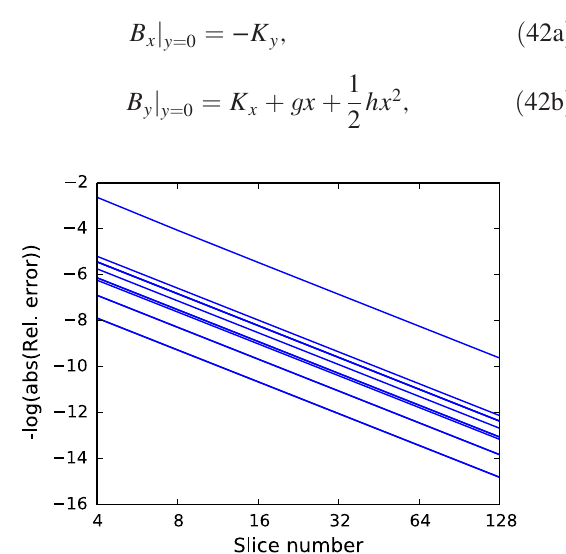
FIG. 2. Counter-check with convergence behavior of the relative errors for the re -coefficients of Fig.